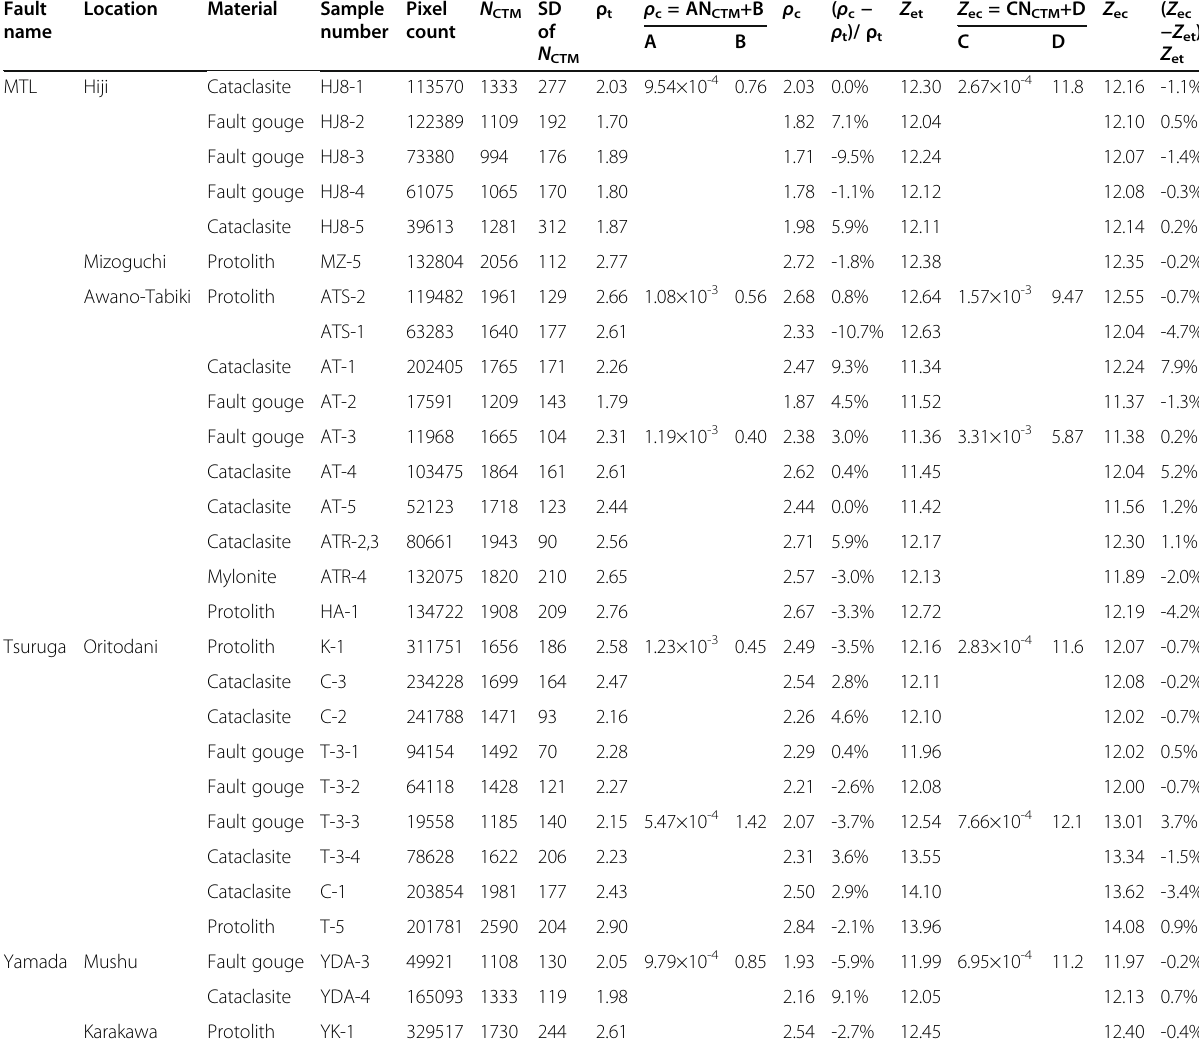
Table 4 Relationship among N CTM (calculated from the CT images at 140kV), ρ t , and Z et for each of the samples Fault Location name MTL